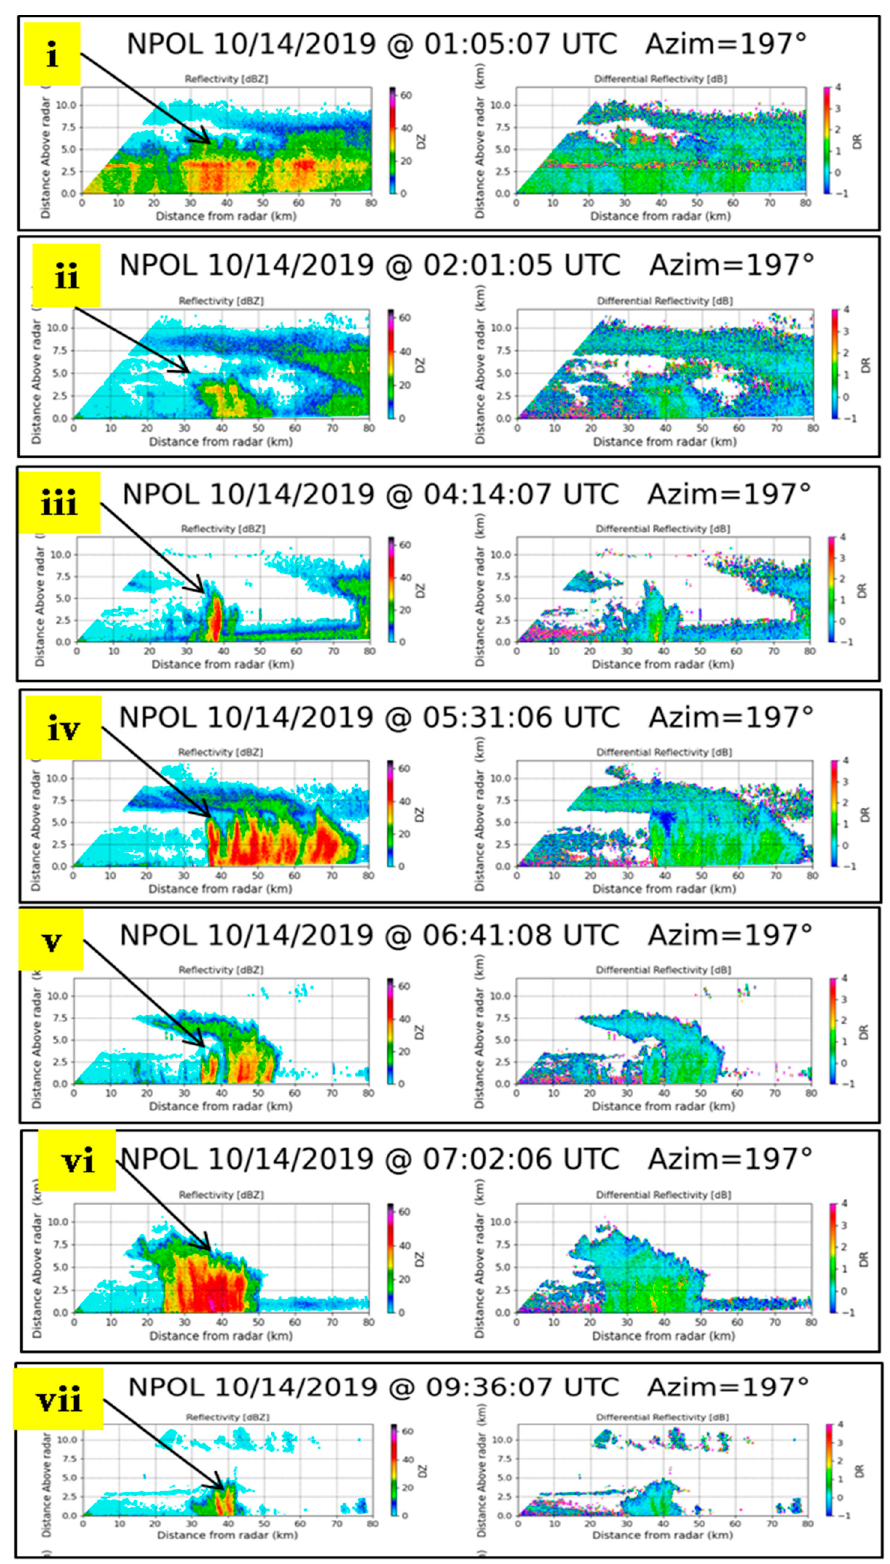
Figure 6. NPOL RHI scans of Z h and Z dr corresponding to cases ( i – vii ) in Figure 5. The arrows point to the vertical profiles above the location of the disdrometers.